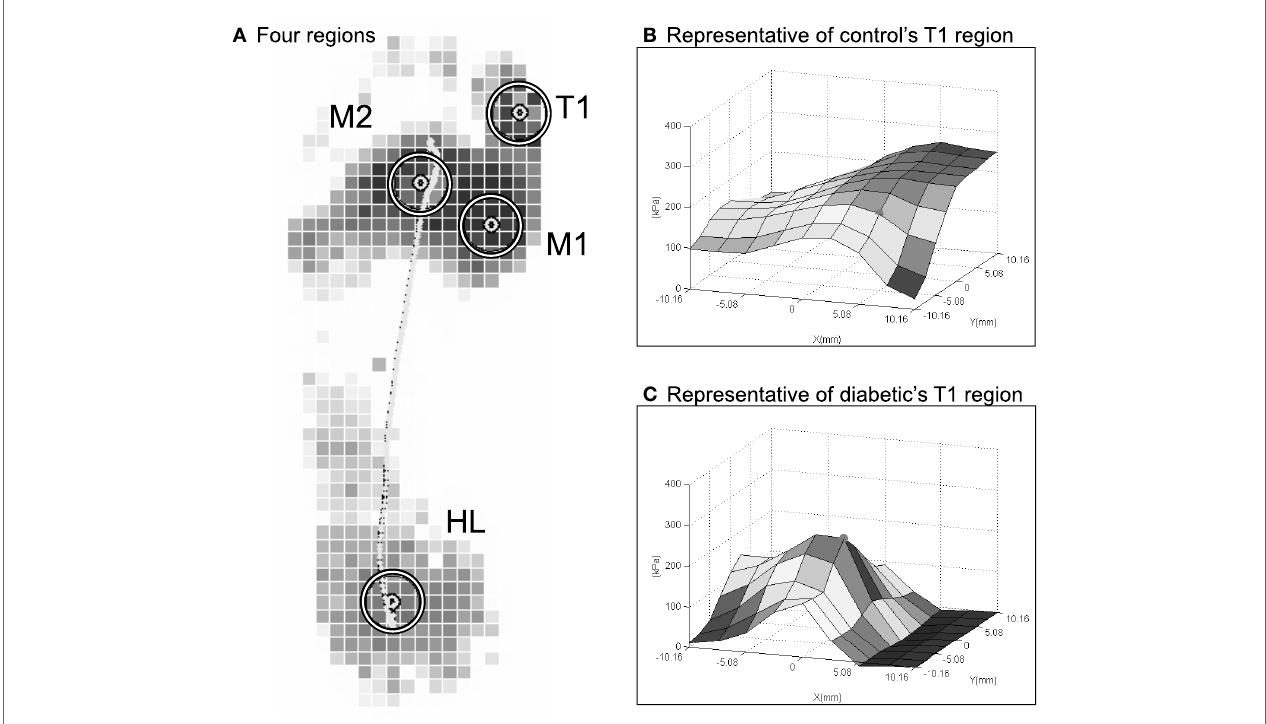
FigUre 2 | examples of PPP angle at the first toe in a representative control and a representative diabetic . (a) Four plantar regions are defined. (B) Control: PPP = 262 kPa, PPG = 29 kPa/mm, and PGA = 135°. (c) Diabetic: PPP = 228 kPa, PPG = 58 kPa/mm, and PGA = 0°. For these two sample cases in (B,c) , the PPP between the control and diabetic are similar, but the PPG and PGA are quite